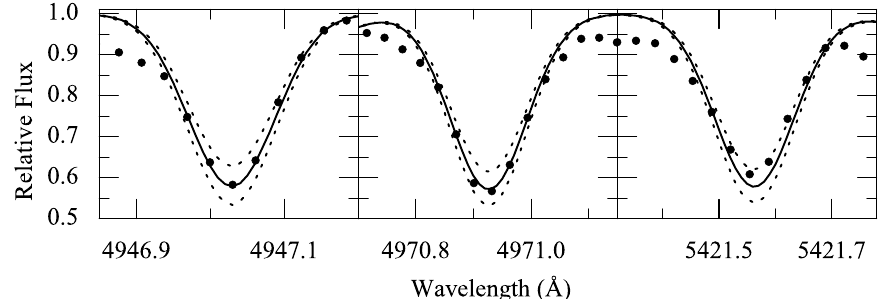
Fig. 20. Nd II lines in the spectrum of HD 209621. The synthetic profiles are given for the three neodymium abundances, log ϵ (Nd) = 1 . 11 ± 0 . 15.